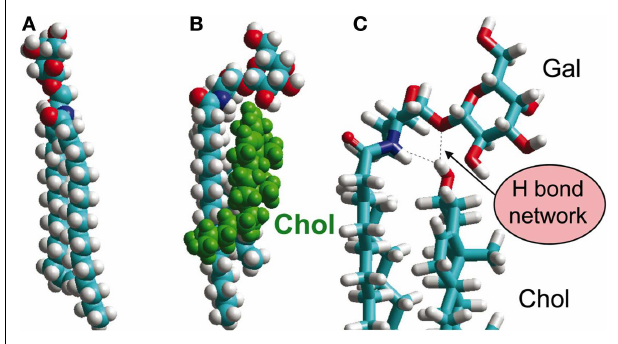
FIGURE 4 | Glycosphingolipid interaction with cholesterol, an important constituent of lipid rafts . (A) GalCer, extended conformation. (B,C) GalCer, tilted conformation, induced by H-bonding interactions with cholesterol OH-group, shown in ( C) [ (A,B) : space-filling representation, (C) : stick representation]. Printed with permission from Ref. (56), in an extension of earlier work by Nyholm et al. (58).